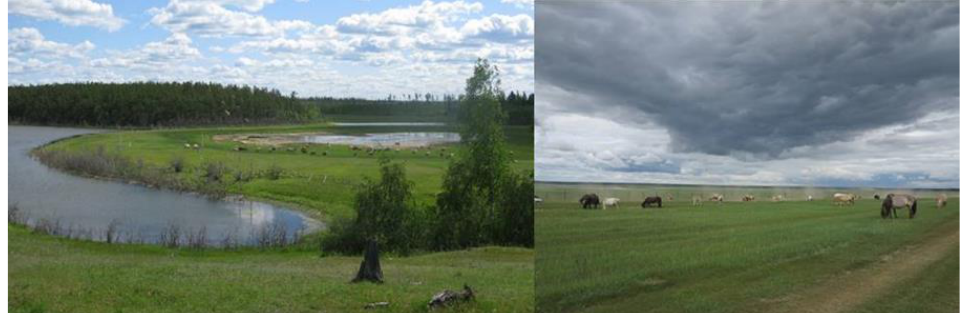
Figure 5. Meadows of alas ecosystems are good pastures.